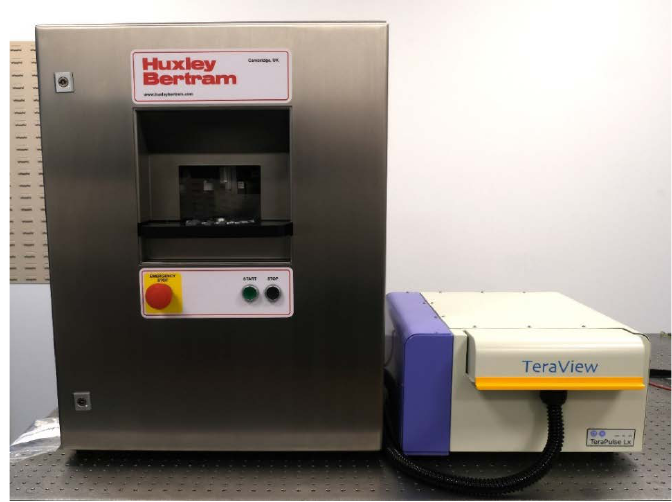
Figure 4. High throughput sampling system for measuring porosity of tablets.